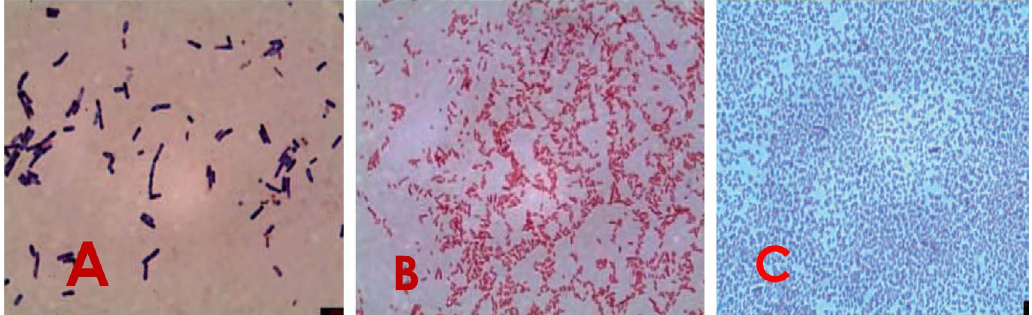
Fig. 2. Microscopic shape of some example of isolated bacteria : A: Bacillus subtilis , (gram stains) (1000X). Bacteria appear gram positive bacilli, B: Sphingomonas paucimobilis , Bacteria appear gram positive rod , C: Staphylococcus lentus , Bacteria appear gram positive cocci. Table 6. Bacterial species isolated from the sediments of studying station Bacteria Gram Shape Color stain Sphingomonas paucimobilis _ Rod shape Yellow Bacillus subtilis + Rod shape Gray-white Pseudomonas aeruginosa _ Rode shape Green Streptococcus thoraltensis + Cocci Yellow Staphylococcus lentus + Cocci Yellow + Bacilli White + Elongated White cocci